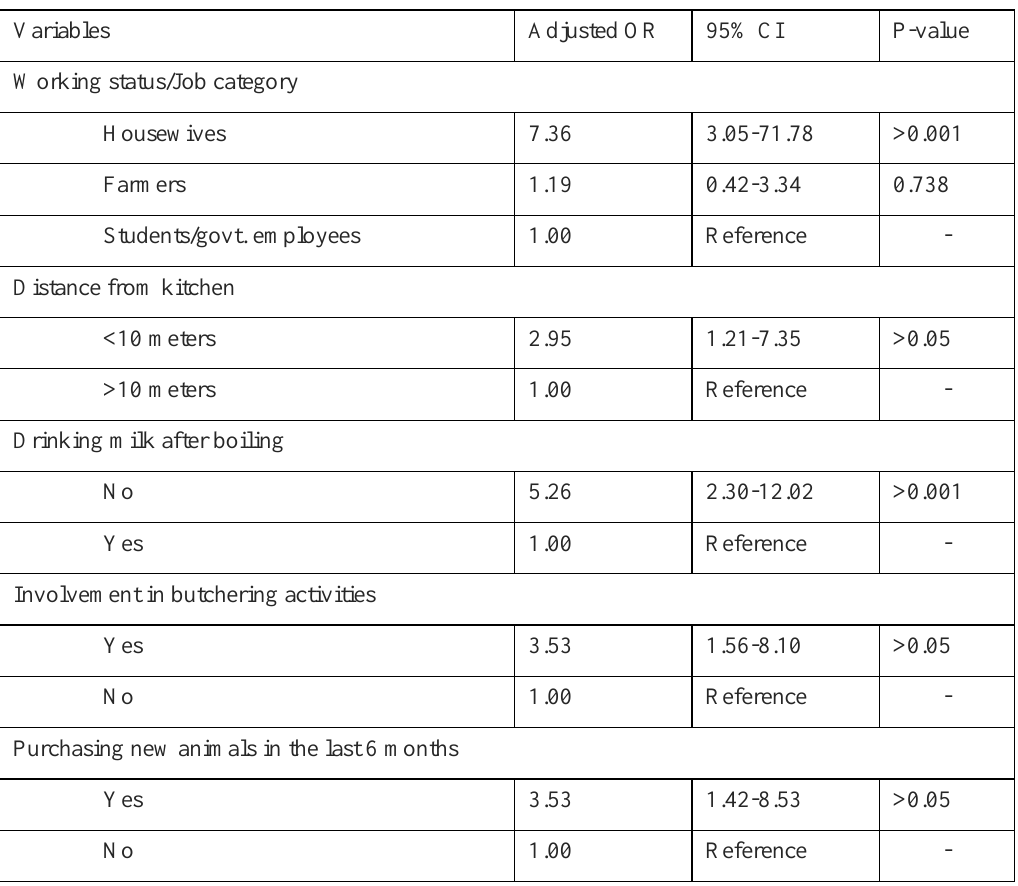
Table 4: Multivariate analysis of risk factors associated with Brucellosis and Q fever in Bamyan